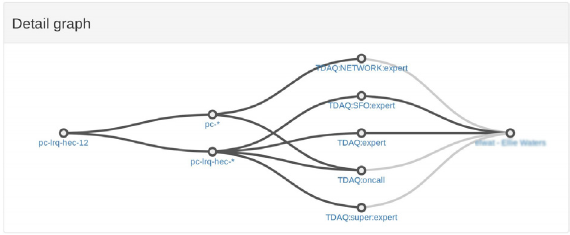
Figure 4. The detailed graph example.